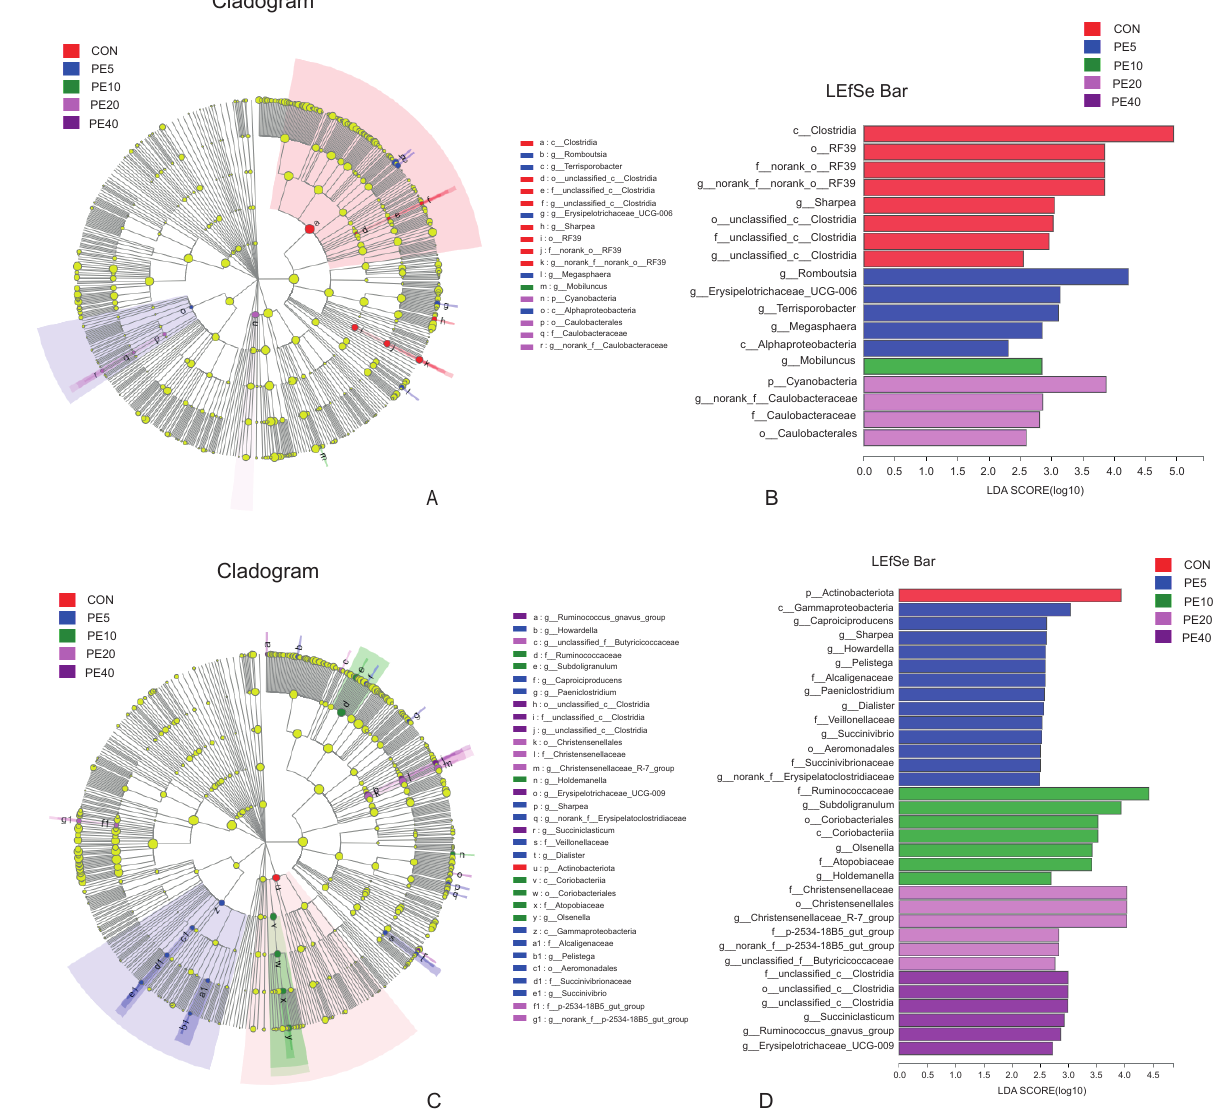
Figure 4. LEfSe analysis (LDA, threshold of 2) of fecal bacterial taxa that were significantly enriched among the groups of calves supplemented with different levels of Amla ( Phyllanthus emblica ) whole- fruit powder at ( A , B ) 28 days of age and ( C , D ) 75 days of age. CON, PE5, PE10, PE20, and PE40 indicate control (0), 5, 10, 20, and 40 g/d/head supplementation of Amla fruit powder, respectively. The LEfSe analysis of rumen fluid samples revealed that only eight taxa were signifi- cantly abundant among the treatment groups, in which one, two, and five taxa were en- riched in CON, PE10, and PE40, respectively, at 14 d (Figure 5A). At 42 d, 28 taxa appeared to be significantly abundant among the treatments, and 17 were in PE5 and PE20 (Figure